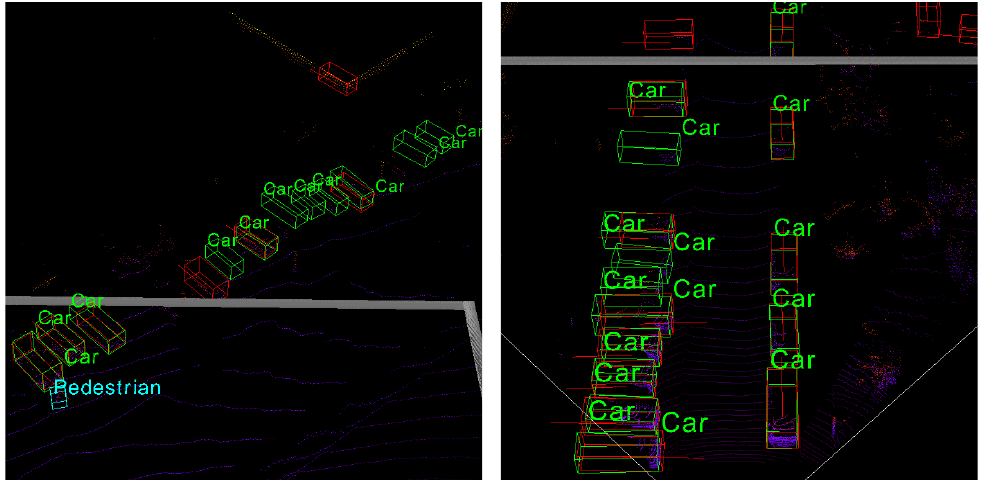
Figure 7. Scenarios of multiple vehicles. The vehicles approach each other, and such scenarios often contain incorrect prediction